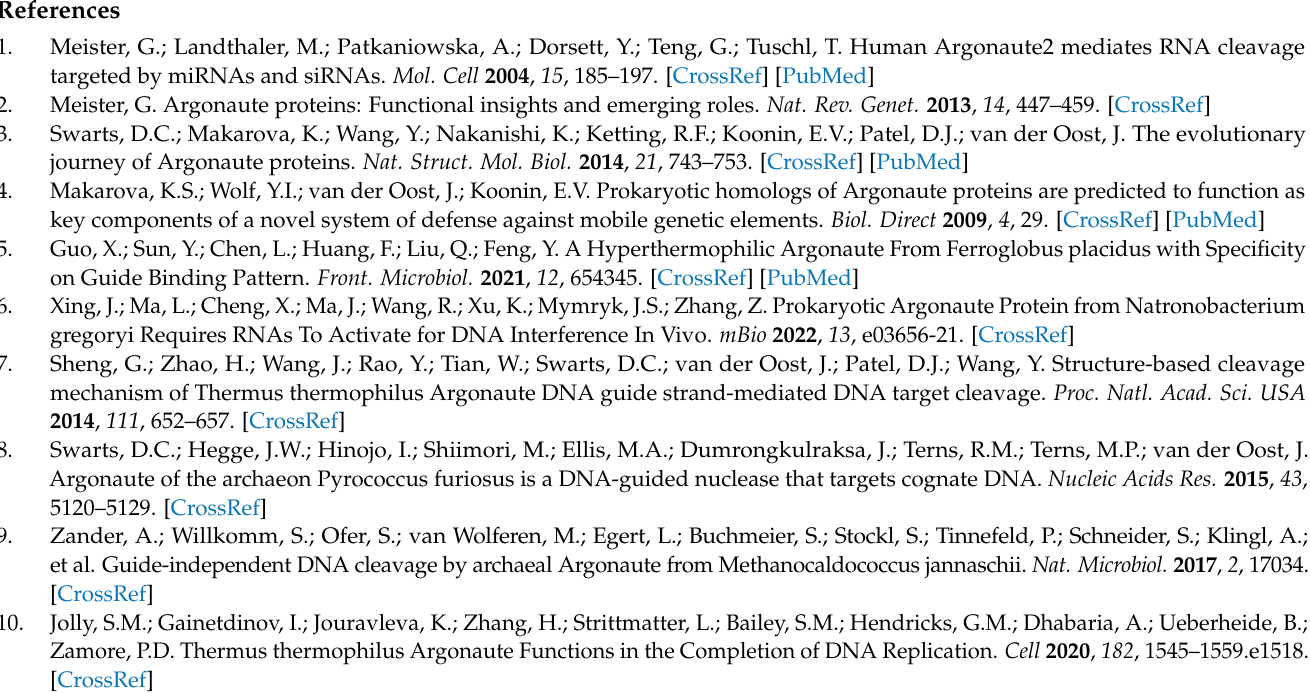
Figure S4. Gel analysis of effects of guide-target mismatches on the cleavage activity of CdAgo; Figure S5. CdAgo stabilization with gDNA; Table S1. Sequences of oligonucleotides used in the ssDNA cleavage assays; Table S2. Sequences of oligonucleotides used in the plasmid DNA cleavage assays; Table S3. Enzymatic characters of different mesophilic pAgos. Table S4. Positions sensitive to mismatch in guide-dependent cleavage by different mesophilic pAgos. Reference [44] is cited in the supplementary